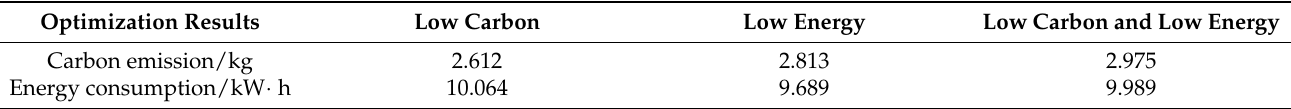
Table 8. Optimization results.